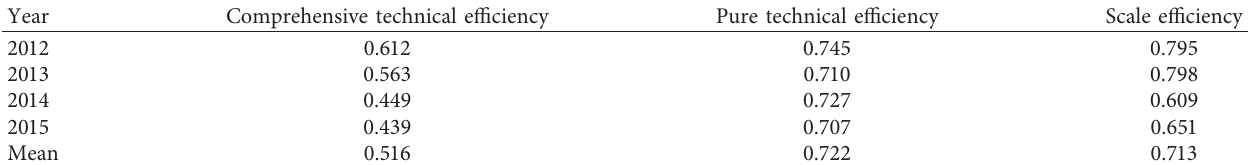
Table 3: Mean annual innovation efficiency of 24 listed companies in the Hubei Development